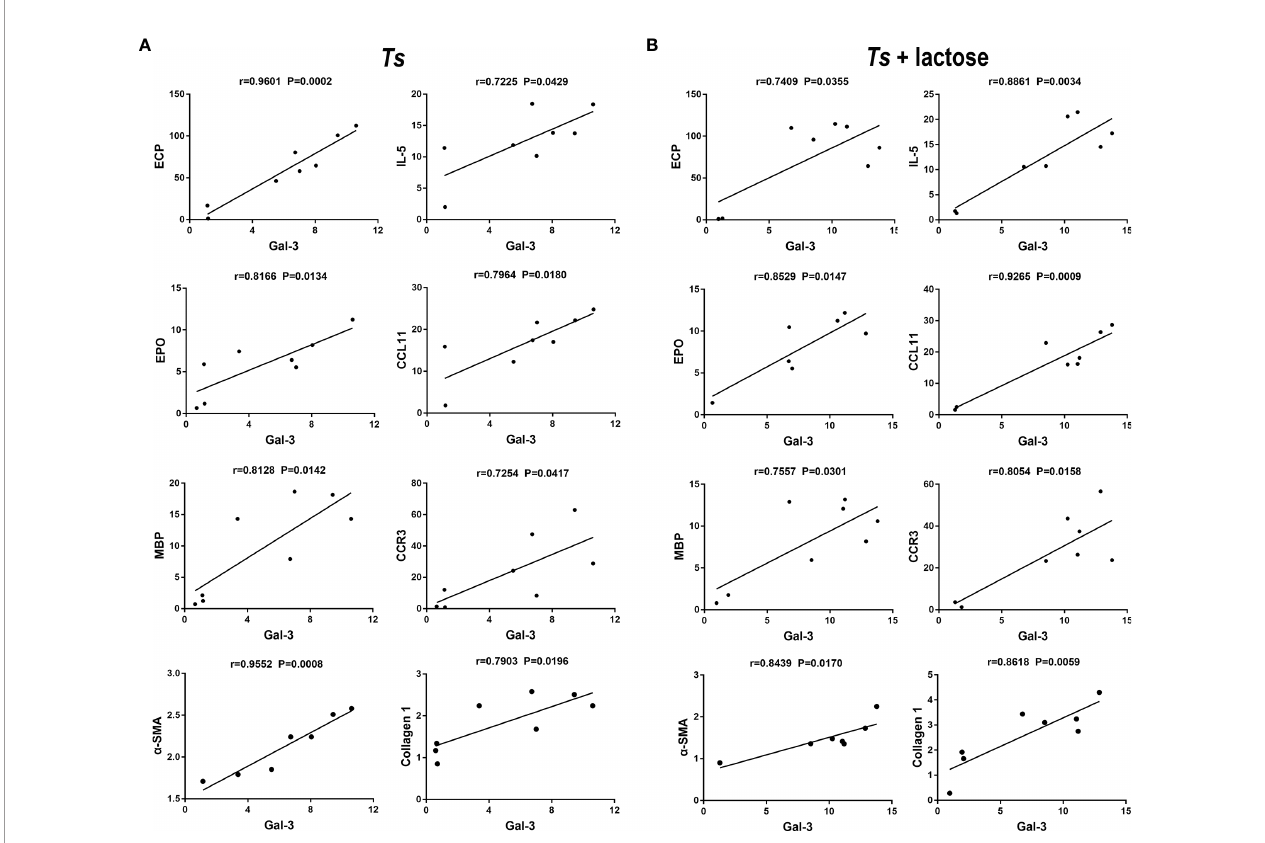
FIGURE 7 | Correlation analysis between the mRNA expression levels of Gal-3 and ECP, EPO, MBP, IL-5, CCL11, CCR3, a -SMA, or collagen 1 in the heart of T. spiralis- infected mice (A) and T. spiralis -infected mice with a -lactose treatment (B) . The r value generates the theoretical line of best fi t, and the P value indicates the signi fi cance of the correlation. There were eight mice in each group and the data shown are representative of those from two different